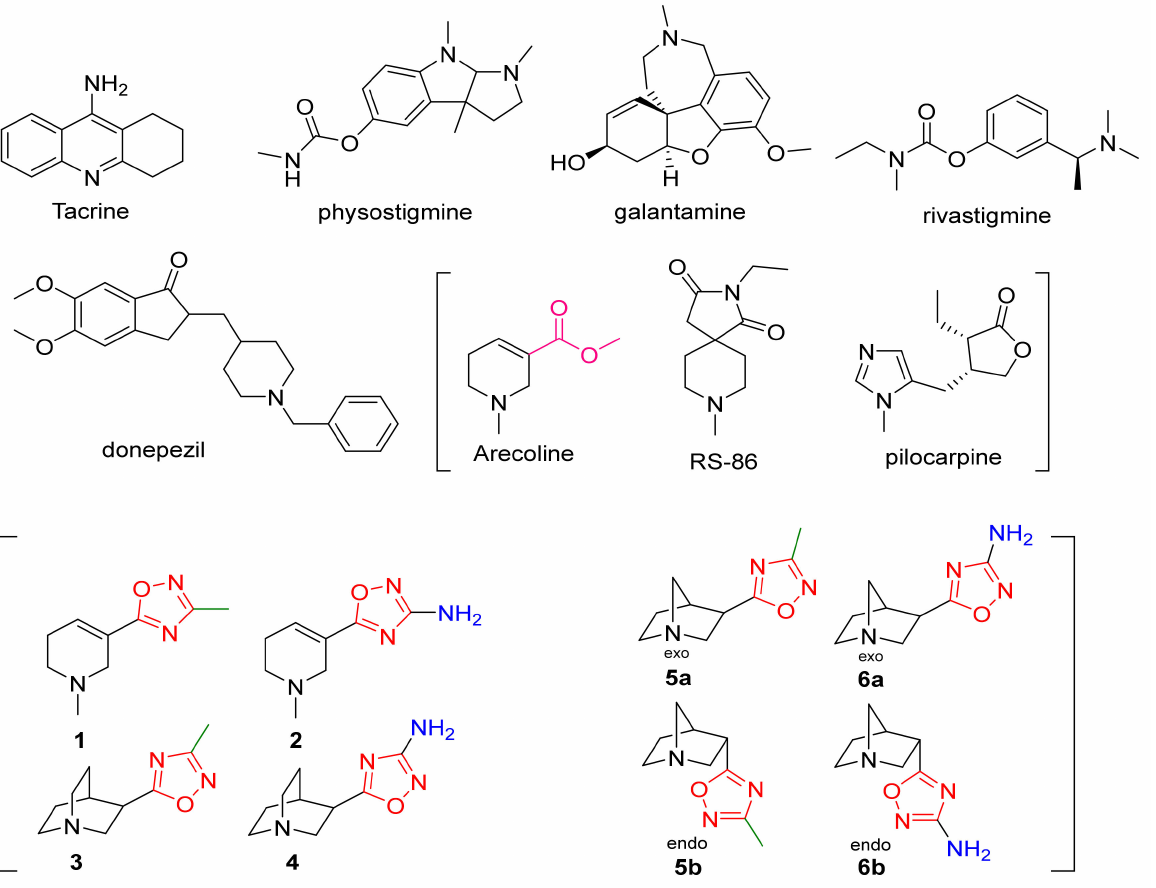
Figure 1. AChEs and direct acting mAChR agonists (brackets).